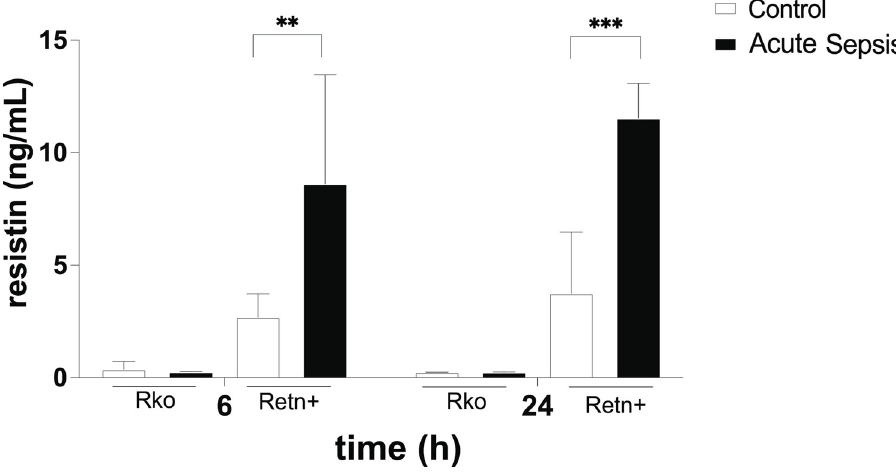
Fig 1. Serum concentrations of human resistin in hRetn-/- mice (Rko) and in hRetn-/- mice transgenic for the human resistin gene (Retn+). Concentrations were measured at 6 h and 24 h post-surgery. n = 3 for Rko with acute sepsis at 6 h and Retn+ with acute sepsis at 24 h; n = 4 for Rko acute sepsis and control at 24 h; n = 6 for Retn+ acute sepsis and control at 6 h; n = 6 for Retn+ control at 24 h; n = 7 for Rko control at 6 h.